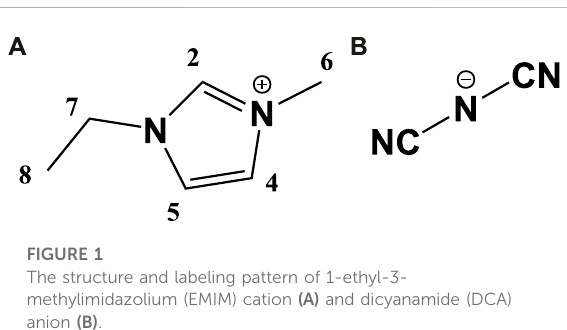
FIGURE 1 The structure and labeling pattern of